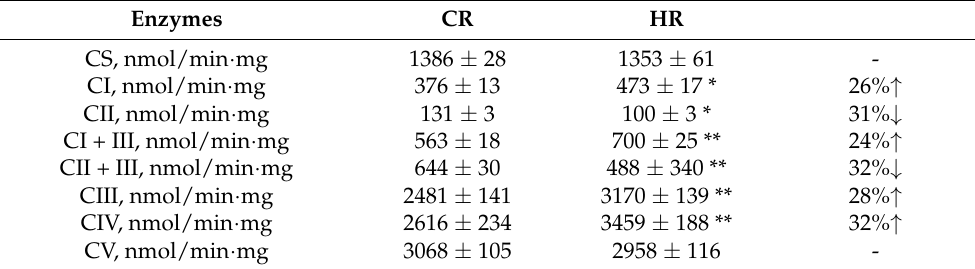
Table 4. Activities of enzymes of ETC and citrate synthase in heart mitochondria from control and hyperthyroid rats.